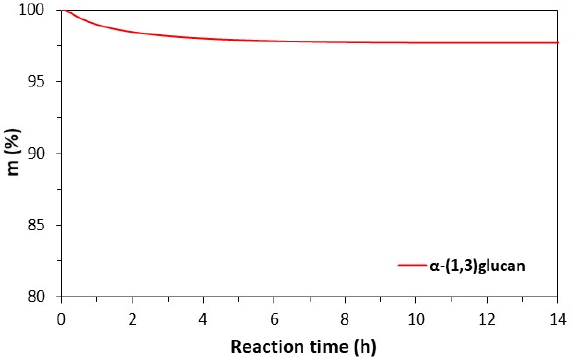
Figure 2. TGA run on the neat α -(1,3) glucan at 130 °C for 14 h.